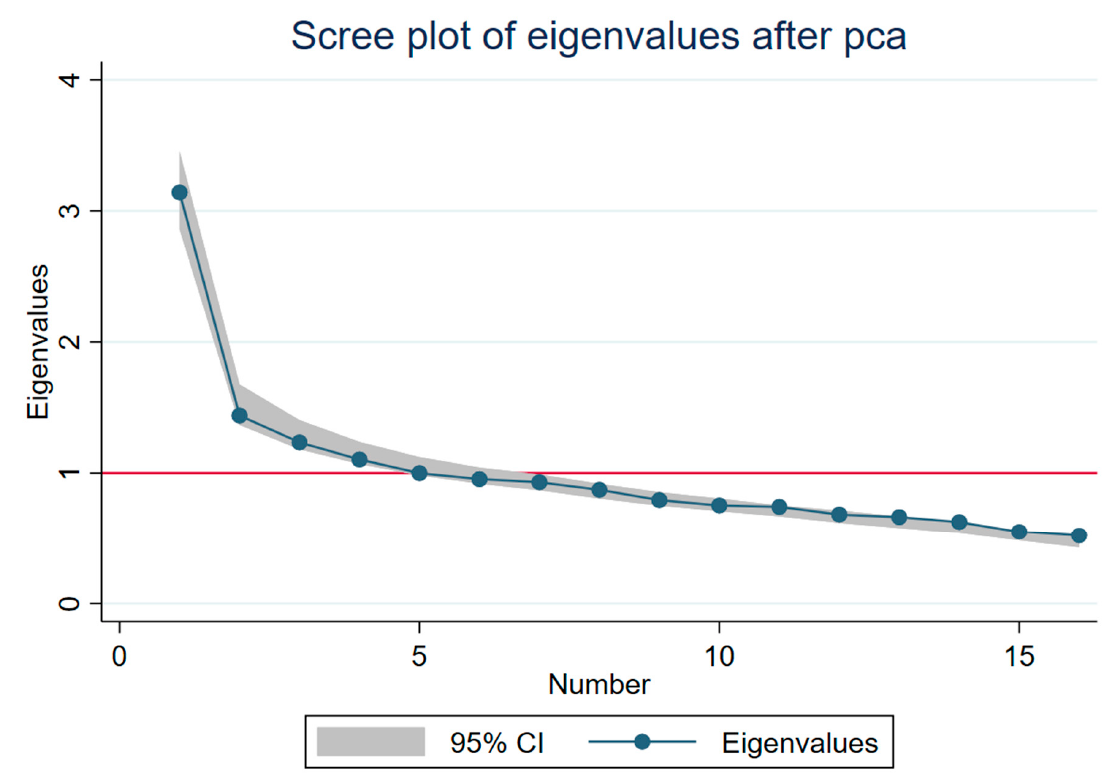
Figure 2. Scree plot of eigenvalues (95% confidence interval) after PCA. Table 4. Factor loading for the three components after varimax rotation.